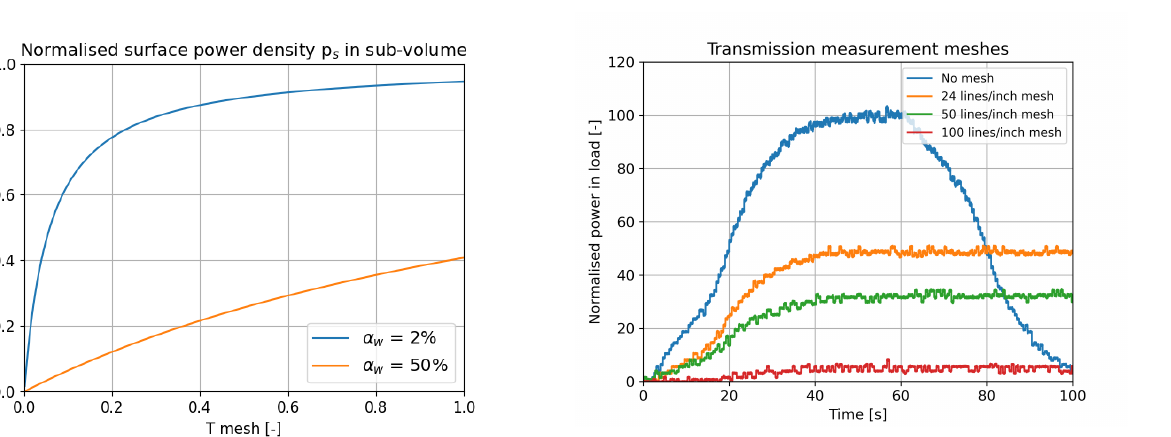
Figure 4. Reduction of stray radiation by using a wire mesh filter with transmission T and for two di ff erent wall absorption coe ffi - cients. While a coating with up to 75% absorption was demon- strated, 50% is shown in the example as usually not all walls are, or can be, coated.